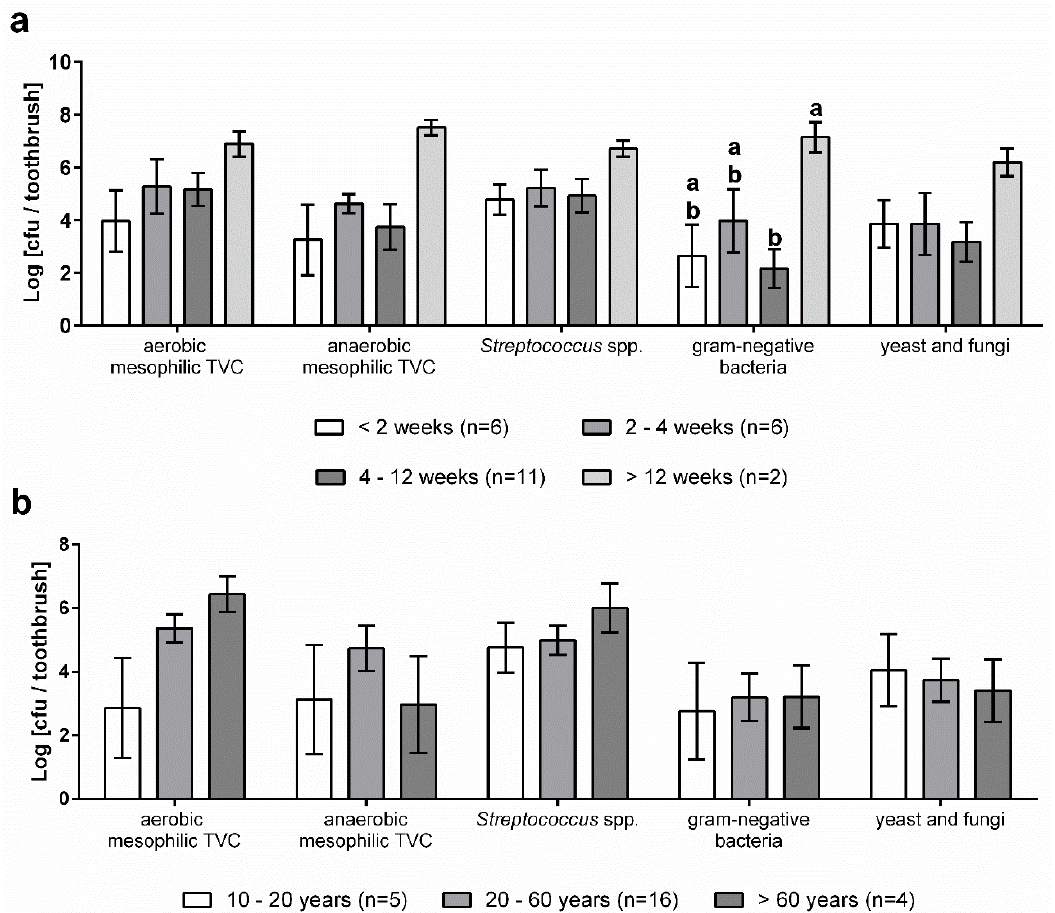
Figure 4. Microbial count of toothbrushes grouped by period of use ( a ) and user age ( b ) on di ff erent culture media. Columns show the mean and standard error of mean ( n = 25). Di ff erent letters indicate significant di ff erences at p ≤ 0.05 (multiple t -test) between groups. Where no letters are shown, no significant di ff erences were detected.